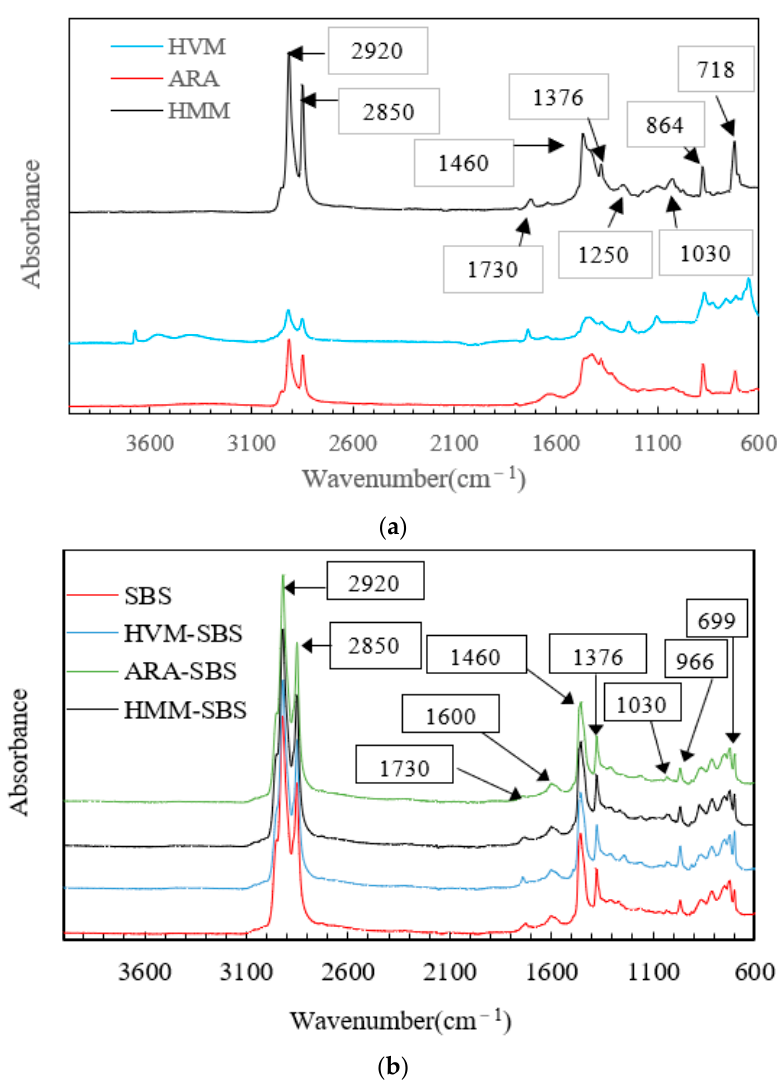
Figure 2. FTIR of polymer additives and asphalt binders before aging: ( a ) polymer additives; ( b ) asphalt binders.